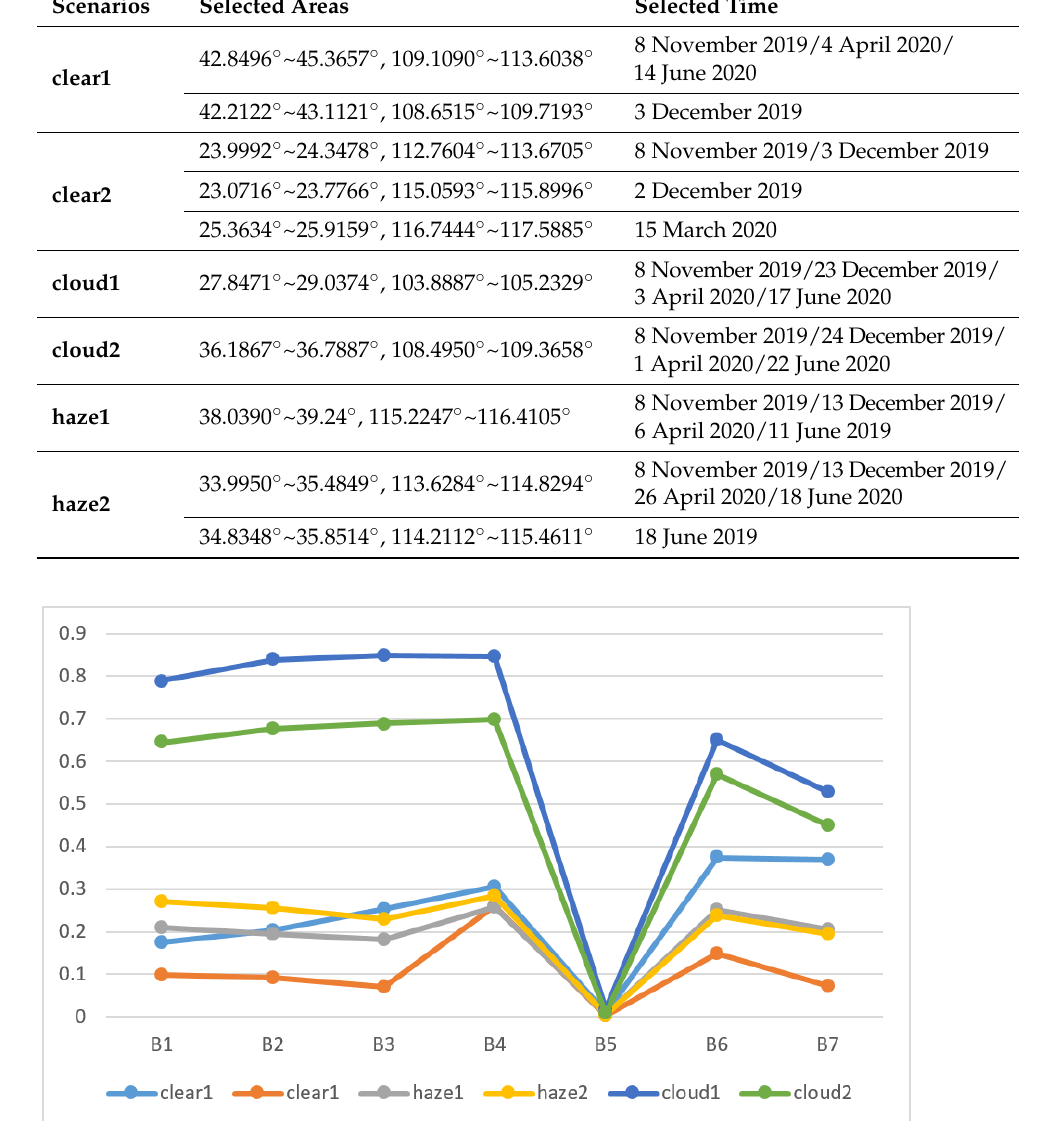
Figure 4. The spectral variation of different pixels over different underlying surfaces using MERSI-II apparent reflectance data. Different colors correspond to the scenarios in Table 2. Table 3. The MERSI-II data set used for training the identification condition with bright surfaces.